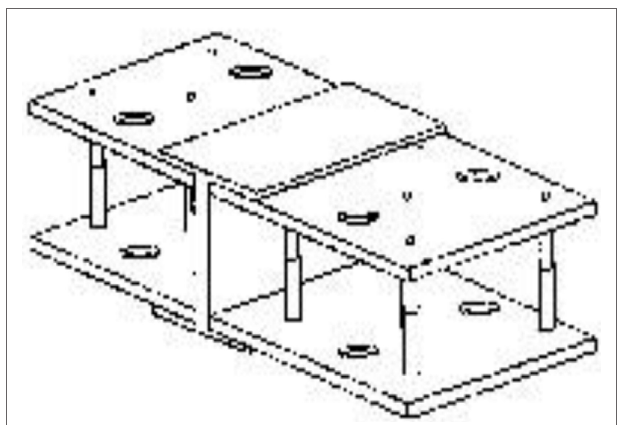
FigUre 2 | Photograph of geosynthetic separation box .